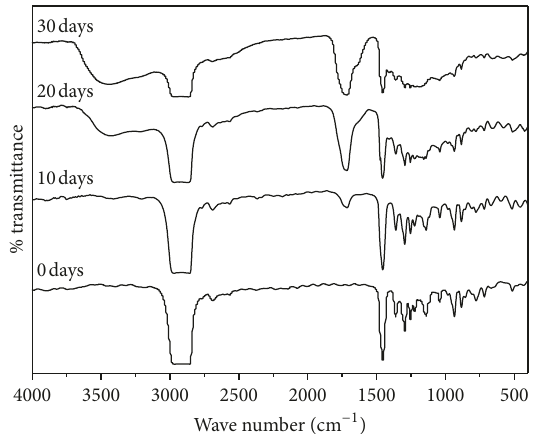
Figure 4: Change in IR of COC 6013 containing Fe prodegradant during photoirradiation.